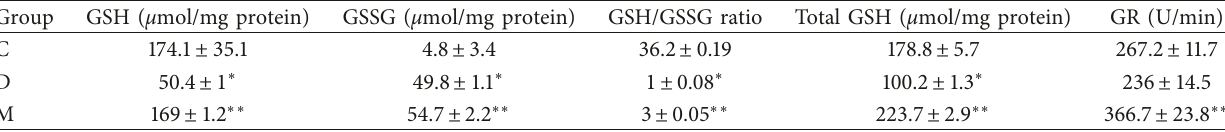
Table 1: GSH and GSSG levels by HPLC-DAD and GR enzymatic activity in liver mitochondria from different groups. Group GSH ( µ mol/mg protein)